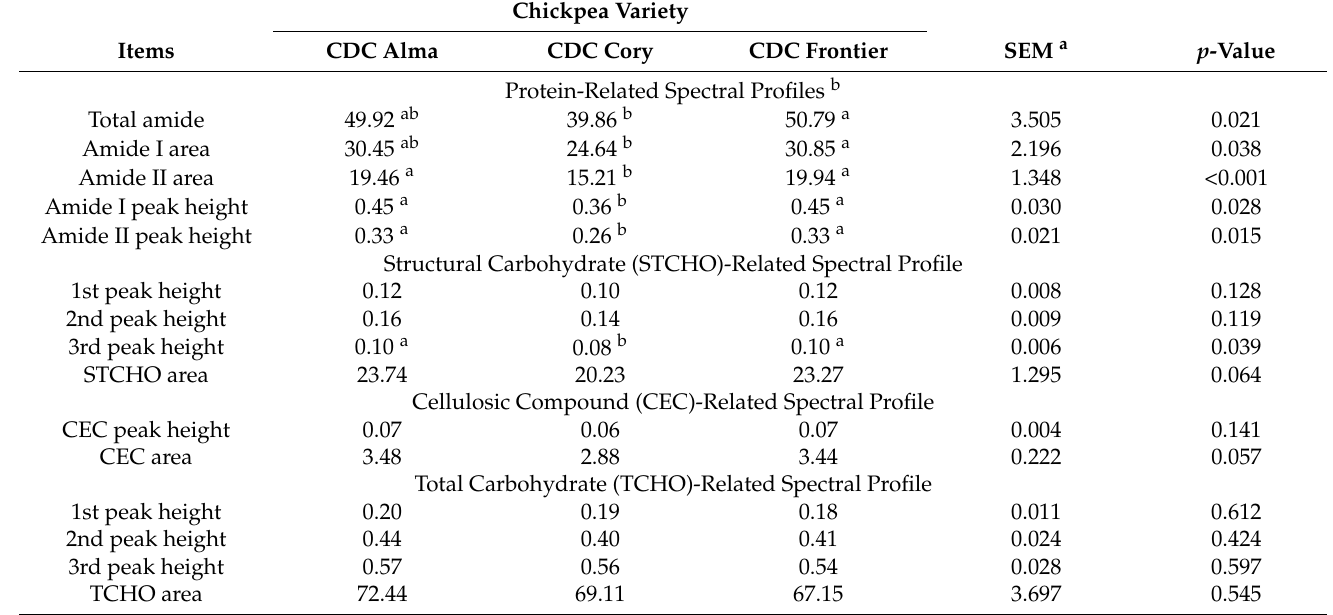
Table 1. Cool-Climate Adapted CDC Genotypes of Chickpeas Grown in Western Canada: Protein and carbohydrate related molecular structures spectral profiles (unit: A.U.) of different chickpea varieties using Fourier-transform infrared attenuated total reflectance molecular